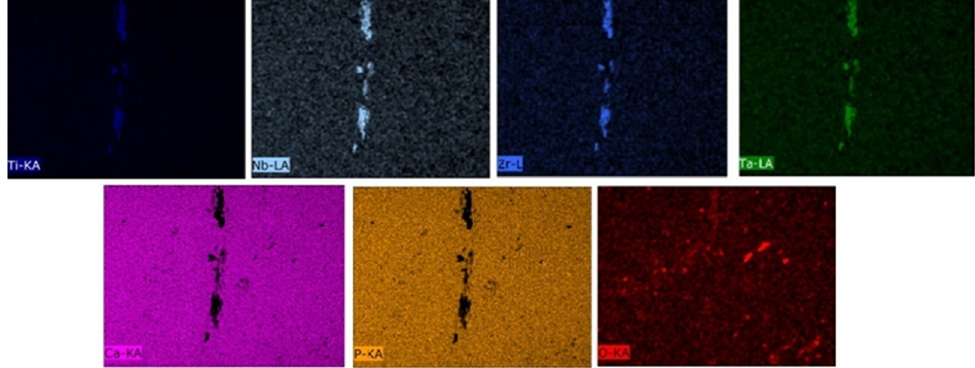
Figure 12. EDS images of each element present in HA coatings deposited on TNZT alloy after the corrosion test.